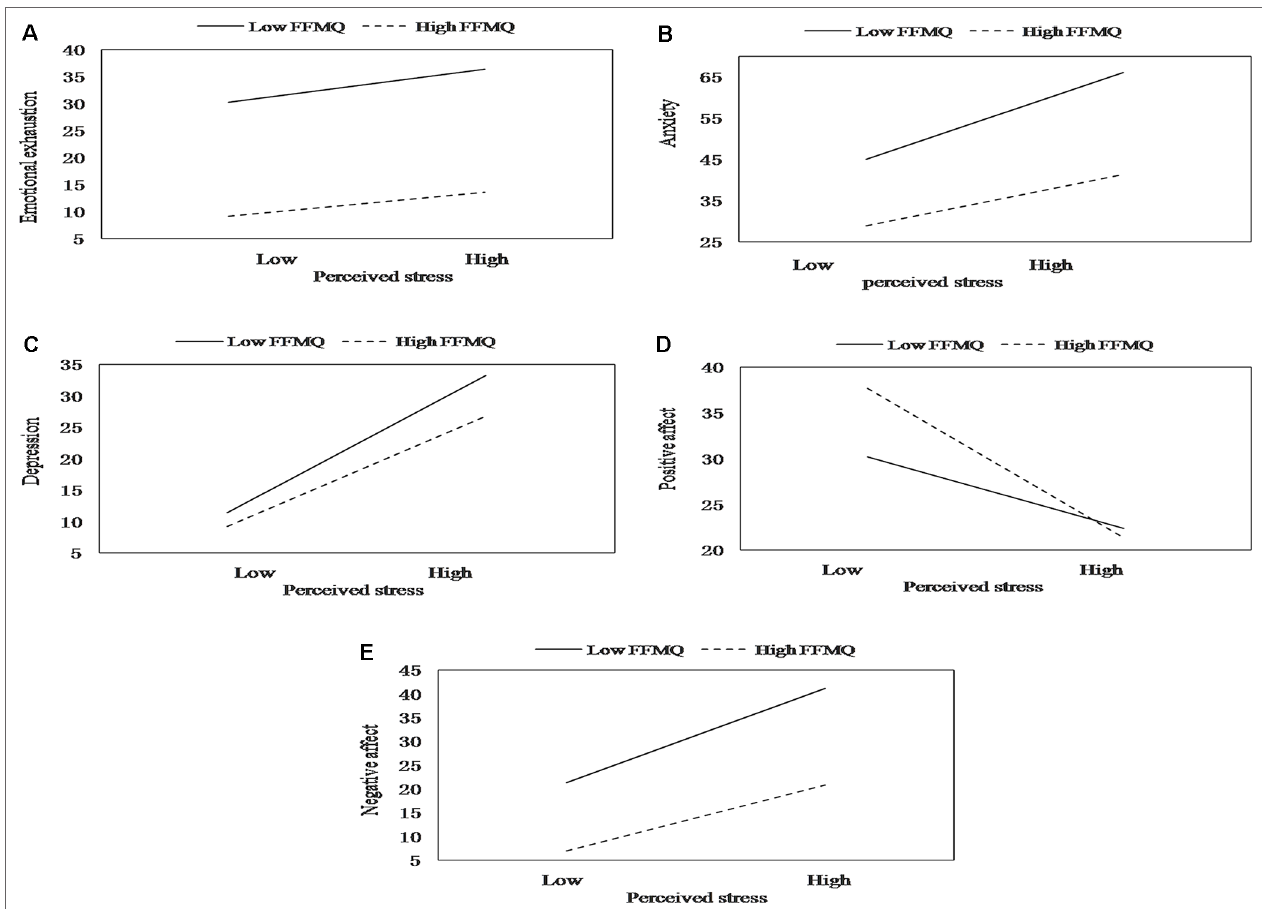
FIGURE 1 | The moderating effect of mindfulness on the relation between stress and emotional exhaustion (A) , depression (B) , anxiety (C) , positive affect (D) , and negative affect (E) .